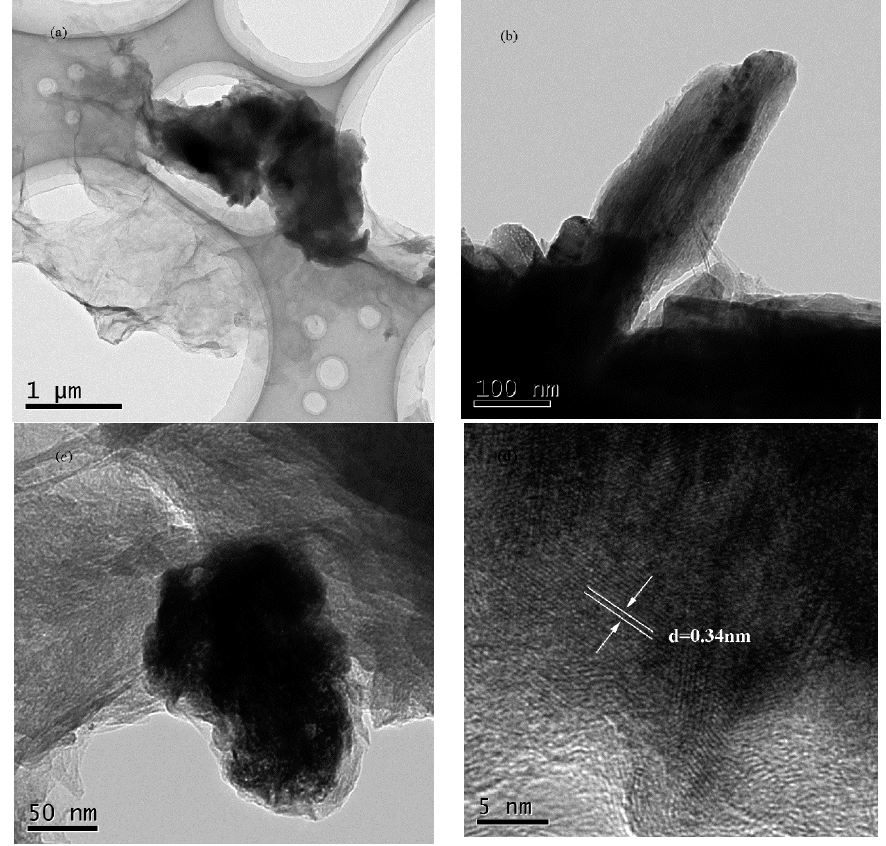
Figure 7. TEM images of the CPGC for 10 h with different scale bar ( a ) 1 μ m; ( b ) 100 n m; ( c ) 50 n m; ( d ) 300 nm.